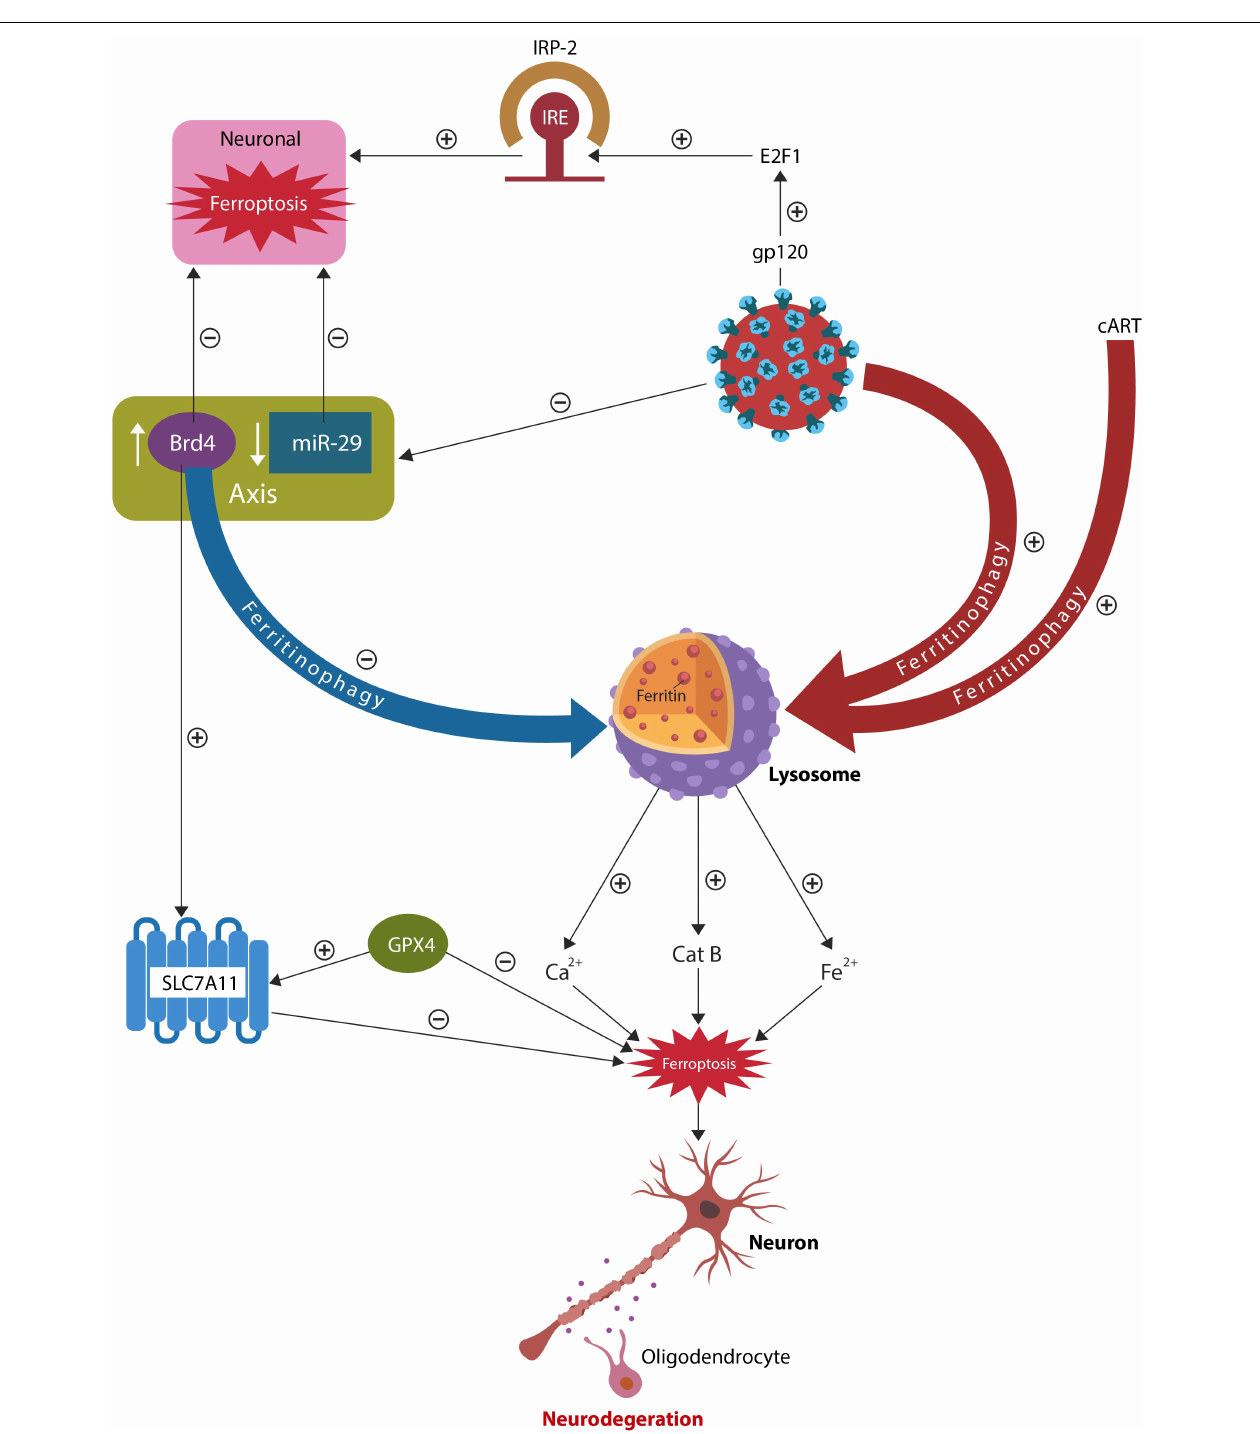
ferritinophagy. The BRD4/miR-29 system also inhibits iron regulatory protein-2 (IRP-2) and augments cystine/glutamate antiporter xCT (SLC7A11), lowering the odds of ferroptosis.